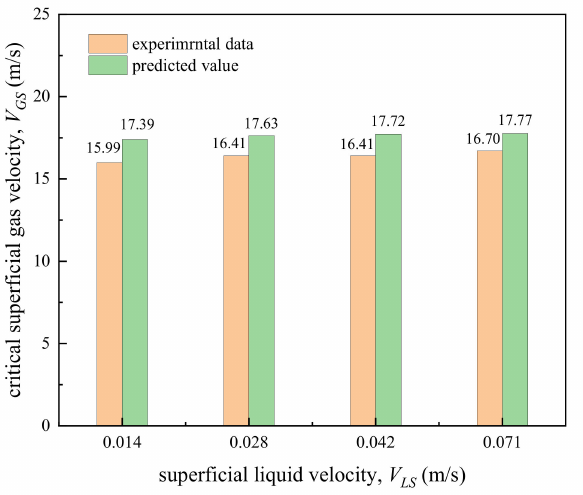
Figure 11. Comparison of experimental and predicted values in this